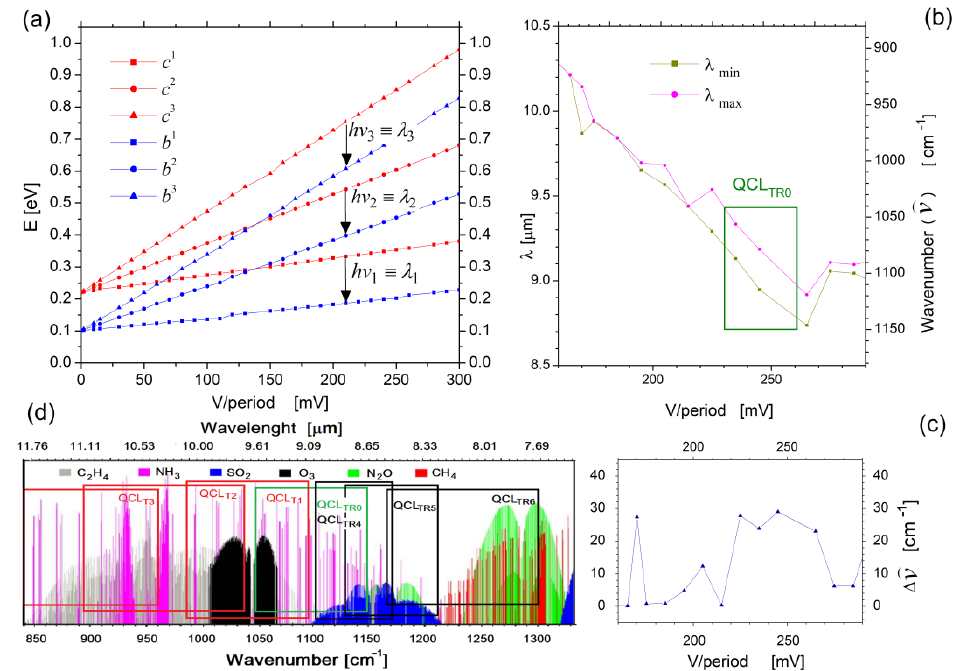
Figure 4. The QCL tuning simulations: ( a ) self-energies for three selected quantum states representing the c -miniband (in red) and the b -miniband (in blue) with marked electron transitions depending on the supply voltage; ( b ) the minimum and maximum values of the transition energies h ν , converted to wavelengths λ , for the two observed minibands ( c and b ) with the effective tunable area QCL TR0 ; ( c ) illustration of wavenumber changes for the calculations shown in part ( b ); ( d ) absorption spectrum of chemical compounds plotted on the basis of HITRAN with marked QCL TR0 tuning area and QCL tuning areas after modifications of the active region described in the next chapter.